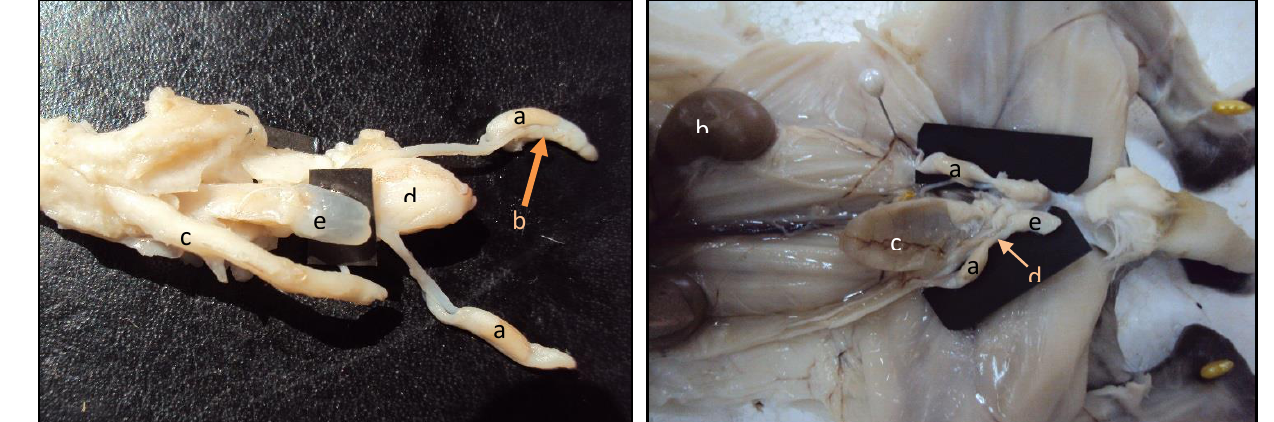
Figure, 4: Show the shape and topographic position of the testes in situ of kit rabbit at 15 days age a- testis b-kidney c- urinary bladder g- gubernaculum e- part of inguinal canal.